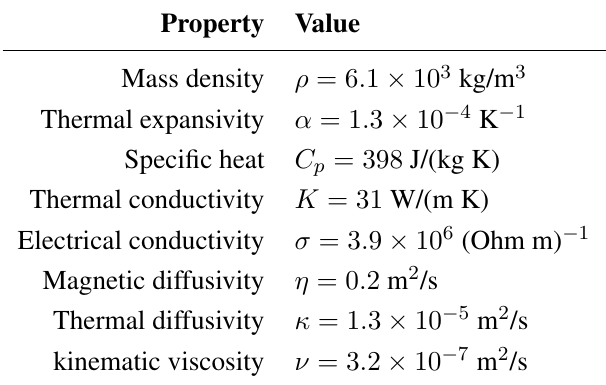
Table 1. Thermophysical properties of liquid gallium. Estimates from